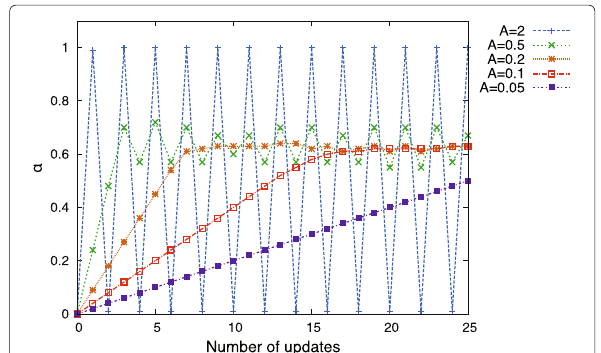
in the IEEE 802.11a standard. The extended slot time was 2 δ RoF + 4 μ